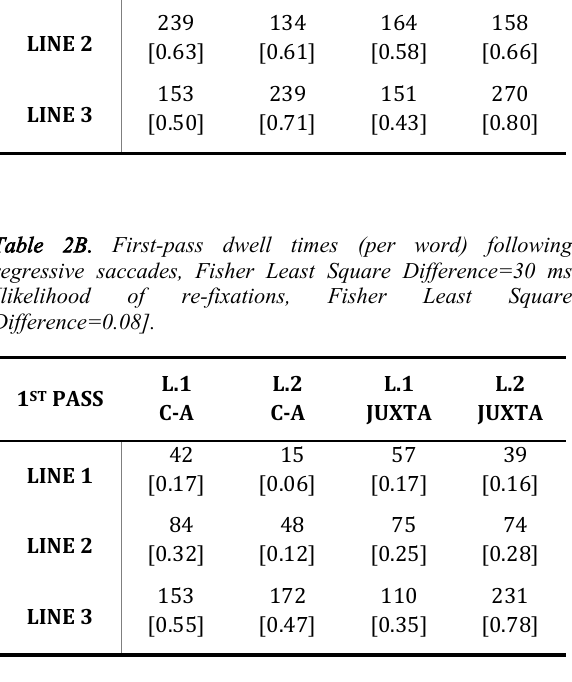
Table 3A. Second-pass dwell times (per word)